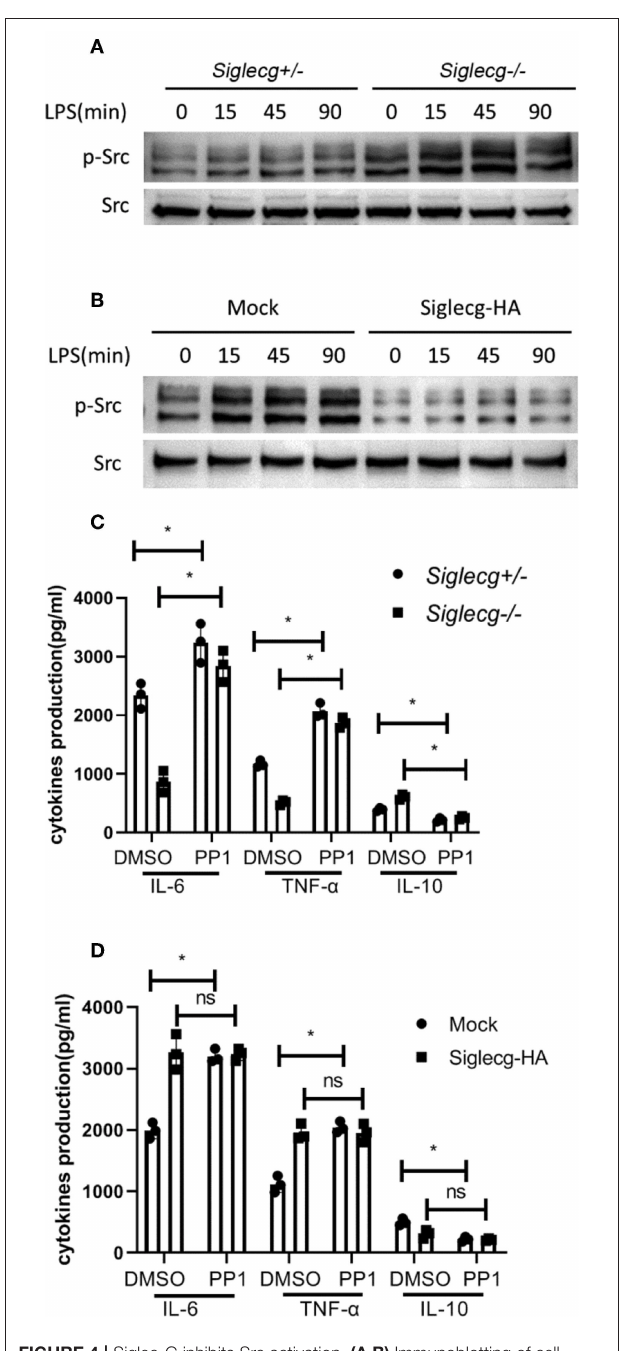
FIGURE 4 | Siglec-G inhibits Src activation. (A,B) Immunoblotting of cell lysates from 2 × 10 6 Siglecg + / − and Siglecg − / − peritoneal macrophages (A) or 3 × 10 6 Siglec-G overexpressing RAW264.7 cells (B) stimulated with LPS (100ng/ml) for the indicated time with indicated antibodies. Data are representative of three independent experiments with similar results. (C,D) ELISA of IL-6, TNF- α , and IL-10 in supernatant from Siglecg + / − and Siglecg − / − peritoneal macrophages (C) or Siglec-G overexpressing RAW264.7 macrophages (D) pretreated with PP1 (5 µ M) for 2h and then stimulated with LPS (100ng/ml) for 12h. Data are representative of three independent experiments with similar results and presented as means ± SD (ns, no significant differences; * P < 0.01). LPS, lipopolysaccharide; IL, interleukin; TNF- α , tumor necrosis factor- α